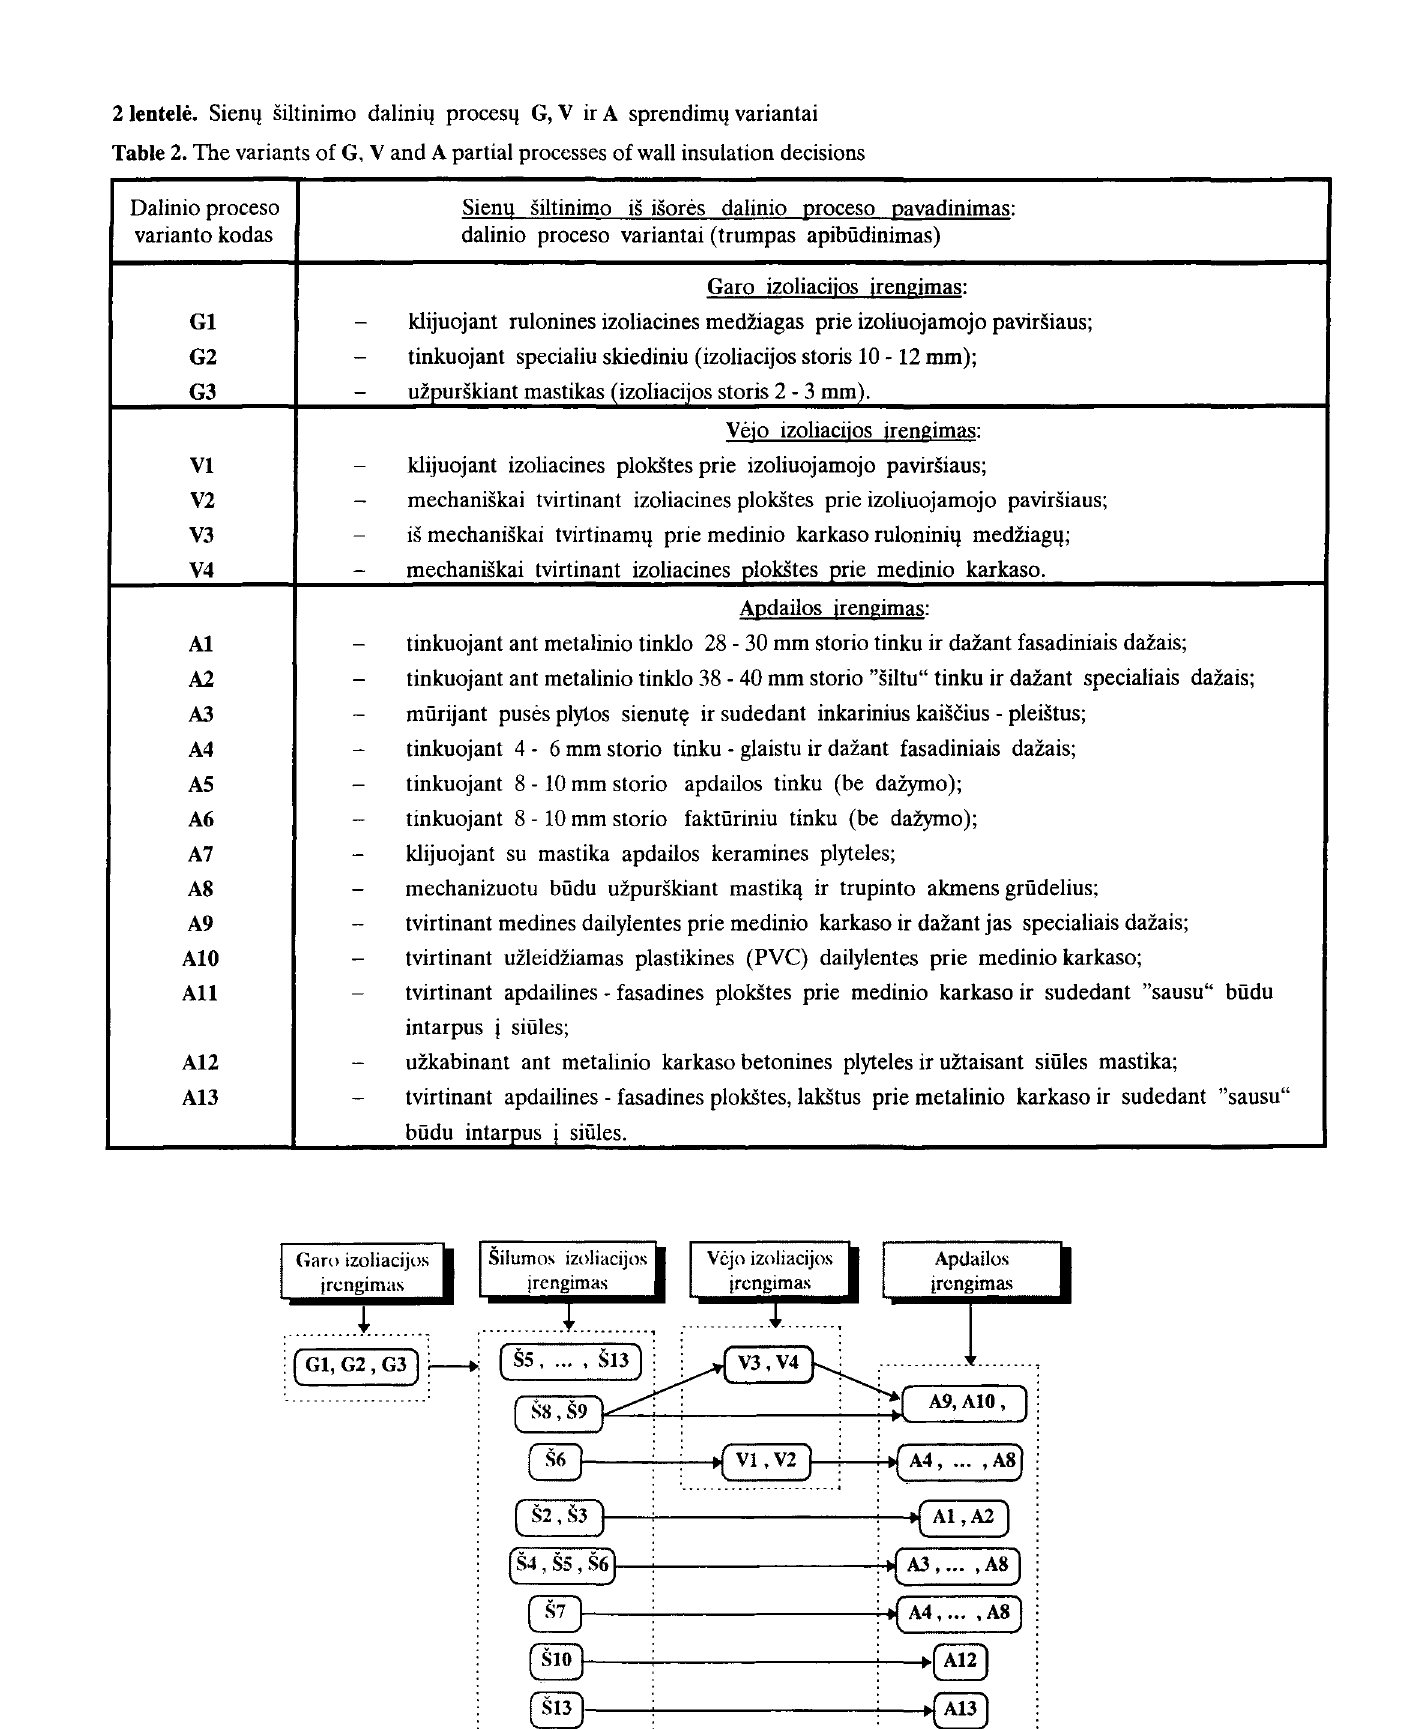
Table 2. The variants of G, V and A partial processes of wall insulation decisions Dalinio proceso varianto kodas